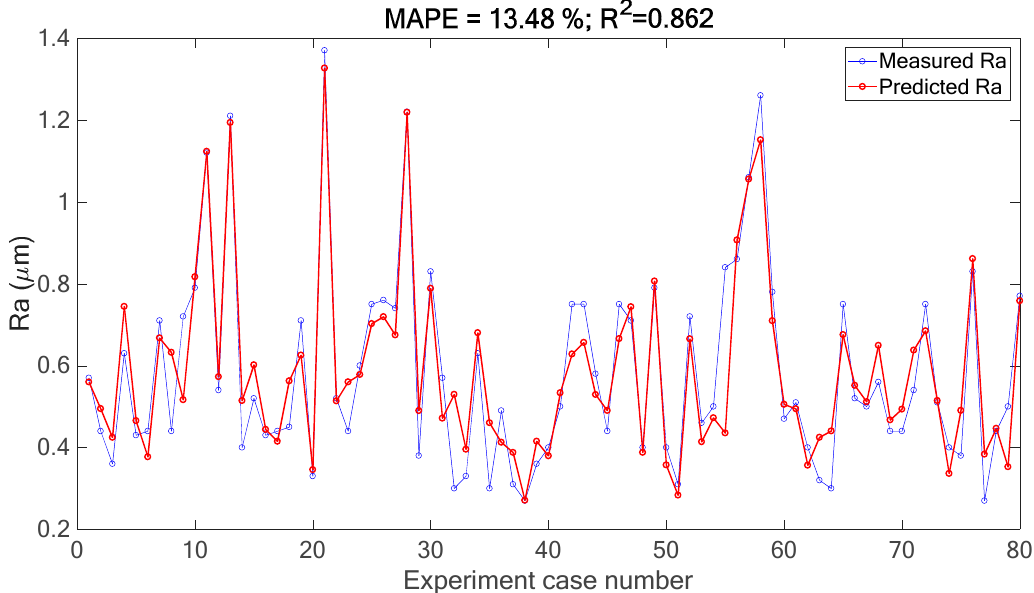
Figure 8. Prediction results of Ra values through Elman neural network by using signal features and cutting parameters.